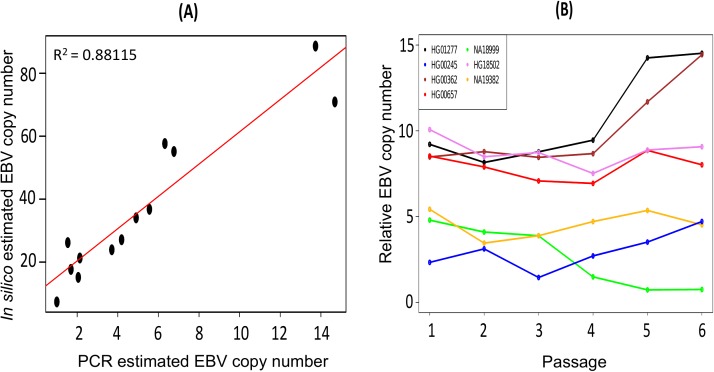
Validation of in silico EBV copy number estimation and EBV stability over time.Correlation between EBV copy number for 13 LCL samples as determined by real-time PCR (X-axis) and in-silico (Y-axis) (A). Relative real-time PCR measurements of EBV copy number in 7 LCLs (shown with different colors) cultured for 6 passages. Viral copy number tends to be stable within one LCL when compared to inter-strain variation (B).